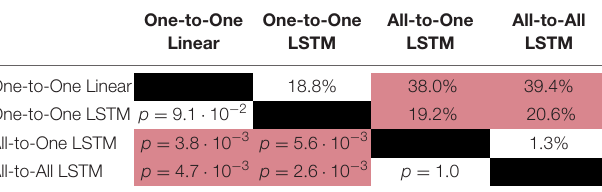
TABLE 5 | Paired absolute differences in median value of the VAF metric across recording sessions (upper triangular part of table), and corresponding p -values (lower triangular part of table), separating regression